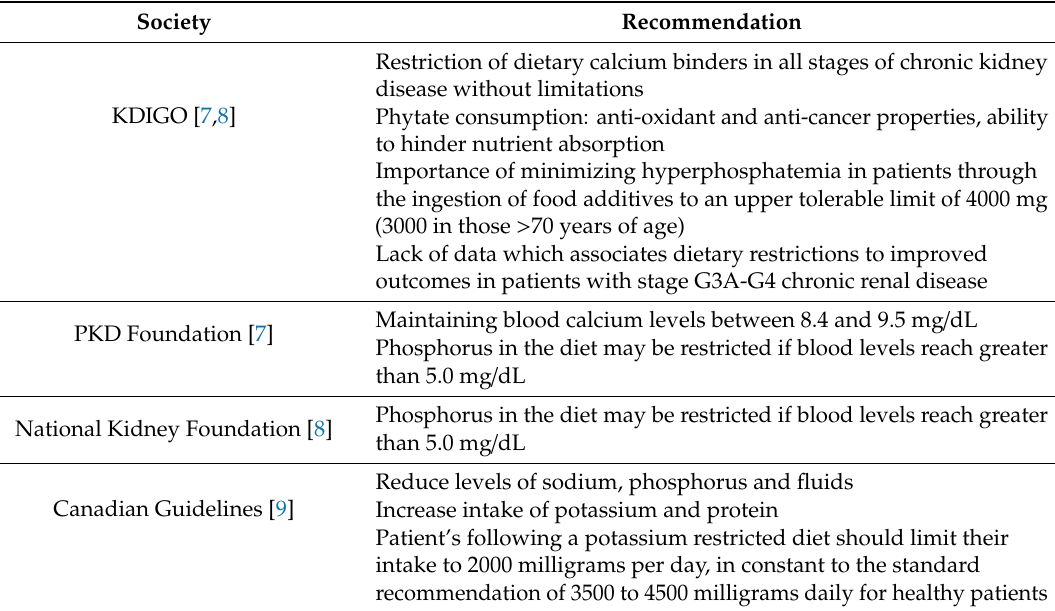
Table 2. Global Nutritional Recommendation in